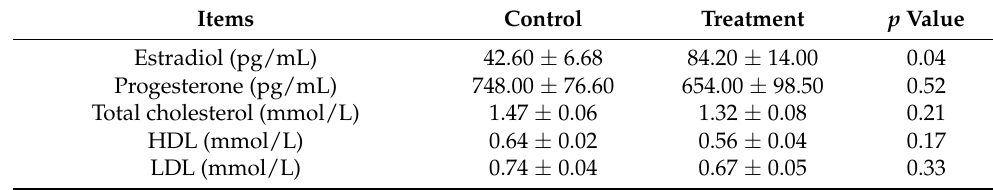
Table 5. Effects of medium- and short-chain fatty acids on reproductive performance of sows 1,2 .